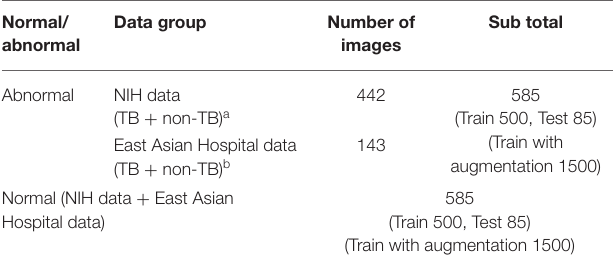
correct collection of the data, two radiologists review dataset TABLE 1 | Data structure for